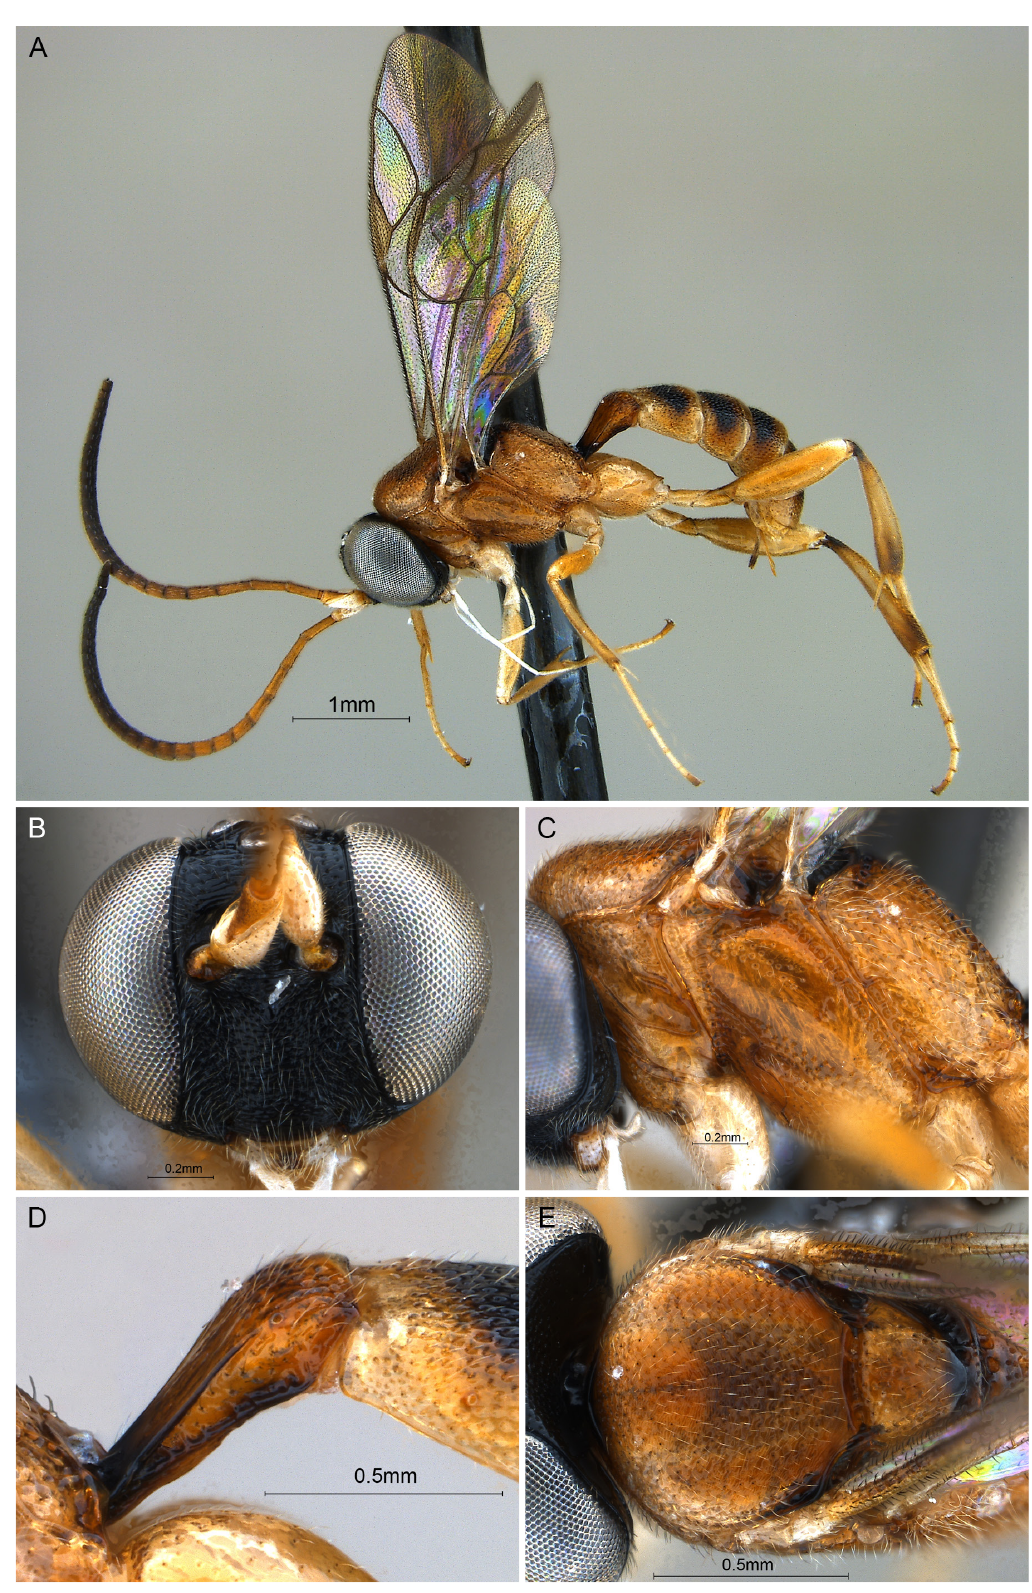
Fig. 13. Palpostilpnus pterodactylus sp. nov., paratype, ♀ (HKU). A . Lateral habitus. B . Head, anterior view. C . Mesopleuron. D . T1, lateral view. E .